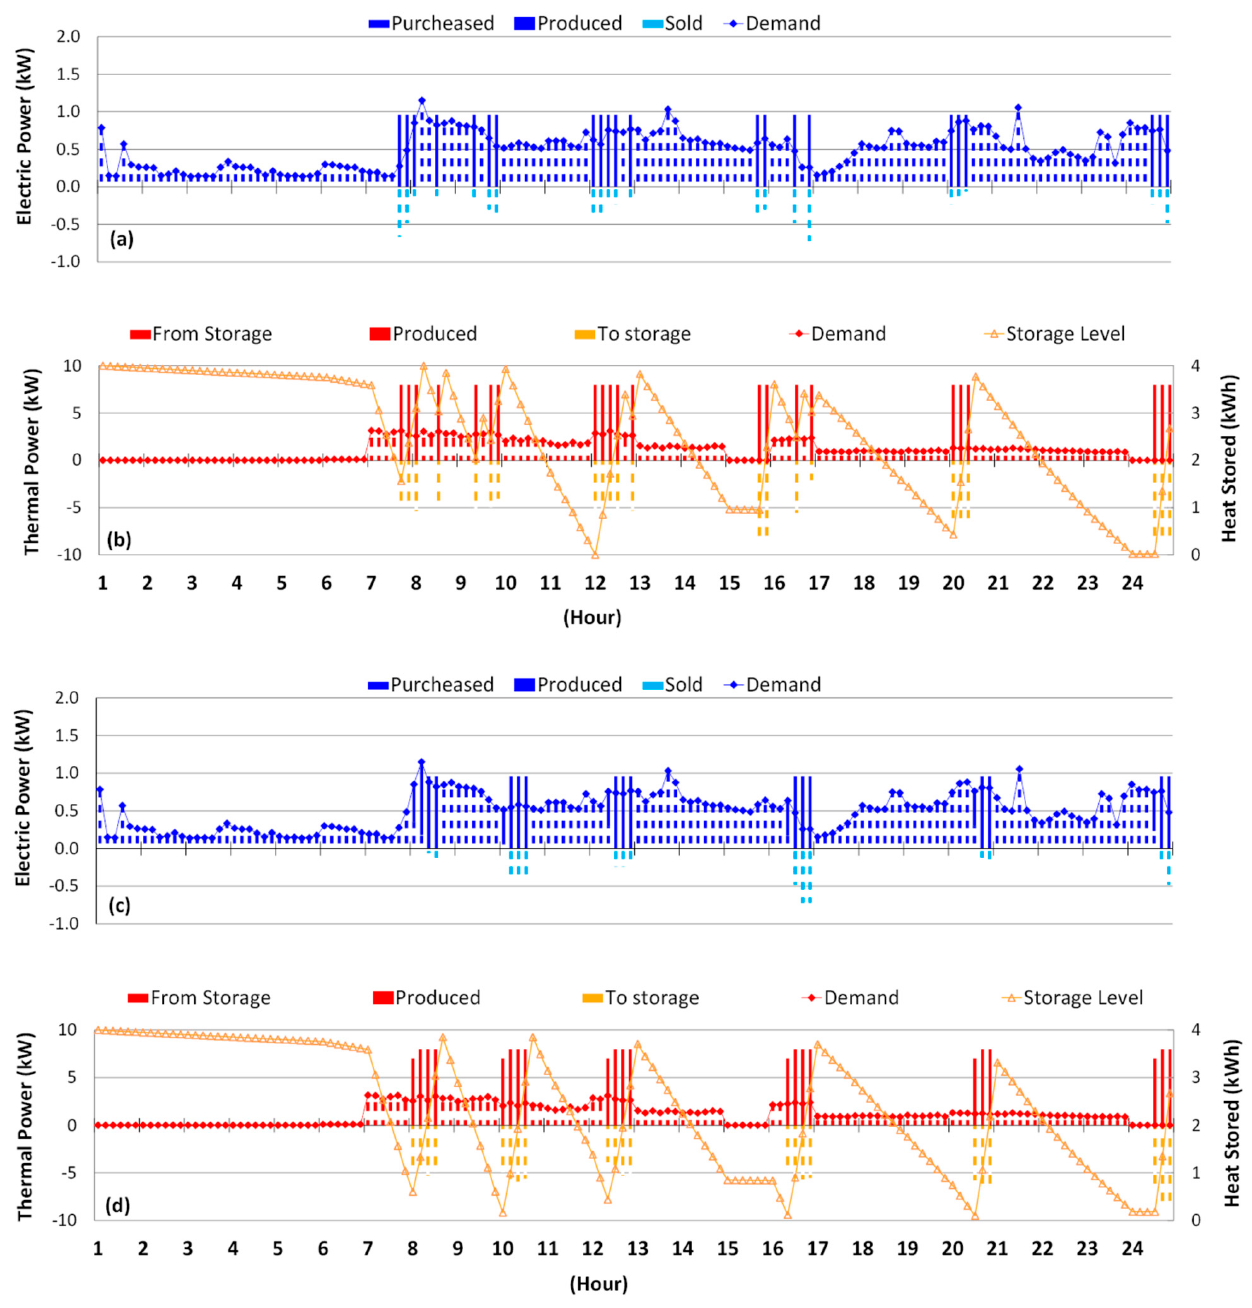
Figure 6. Computational results for a 4 kWh thermal storage capacity (out of which 1 kWh was due to the heating system and 3 kWh to the thermal storage tank): ( a ) Electric and ( b ) thermal scheduling without startup and shutdown penalization; ( c ) electric and ( d ) thermal scheduling with startup and shutdown penalization.